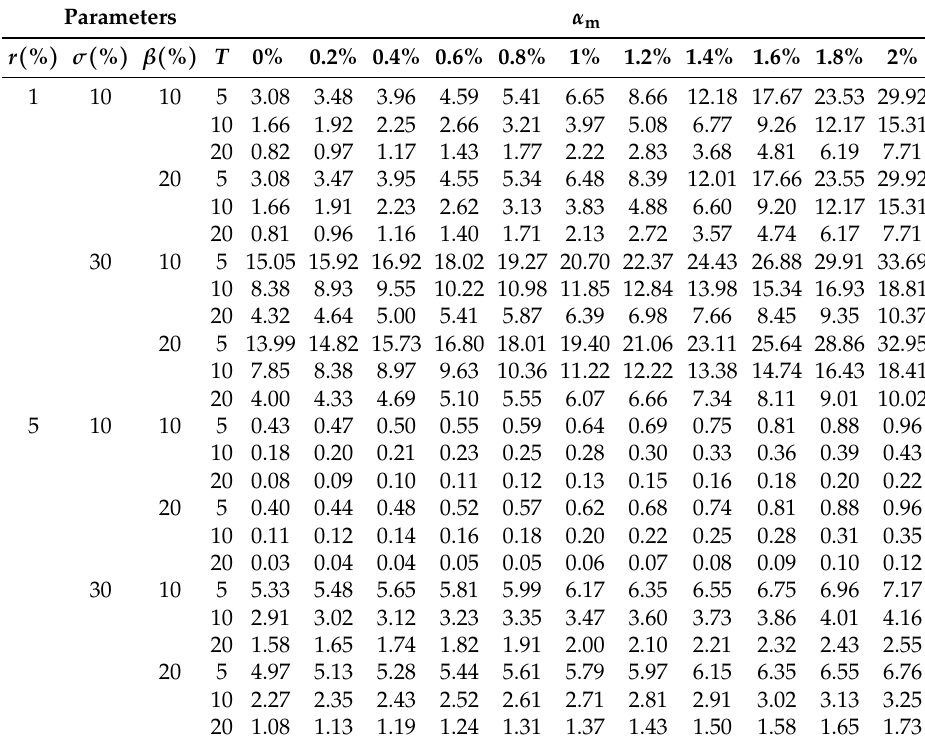
Table 1. Fair fee rate α ins (%) based on the guarantee value maximization strategy Γ G .